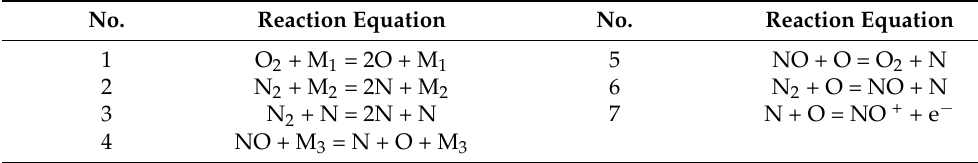
Table 2. Chemical reactions of high-temperature air within the hybrid kinetic scheme.